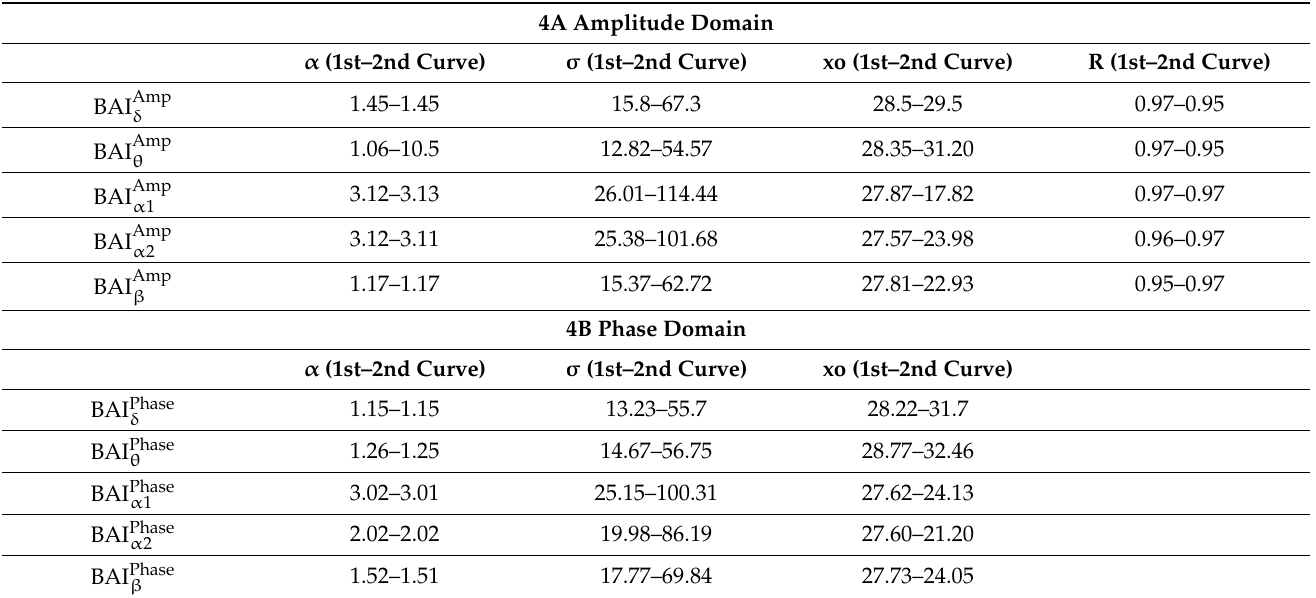
Table 4. Parameters of the non-centred, non-normalised Gaussian fit model to BAI across frequency bands for the whole cohort for amplitude and phase